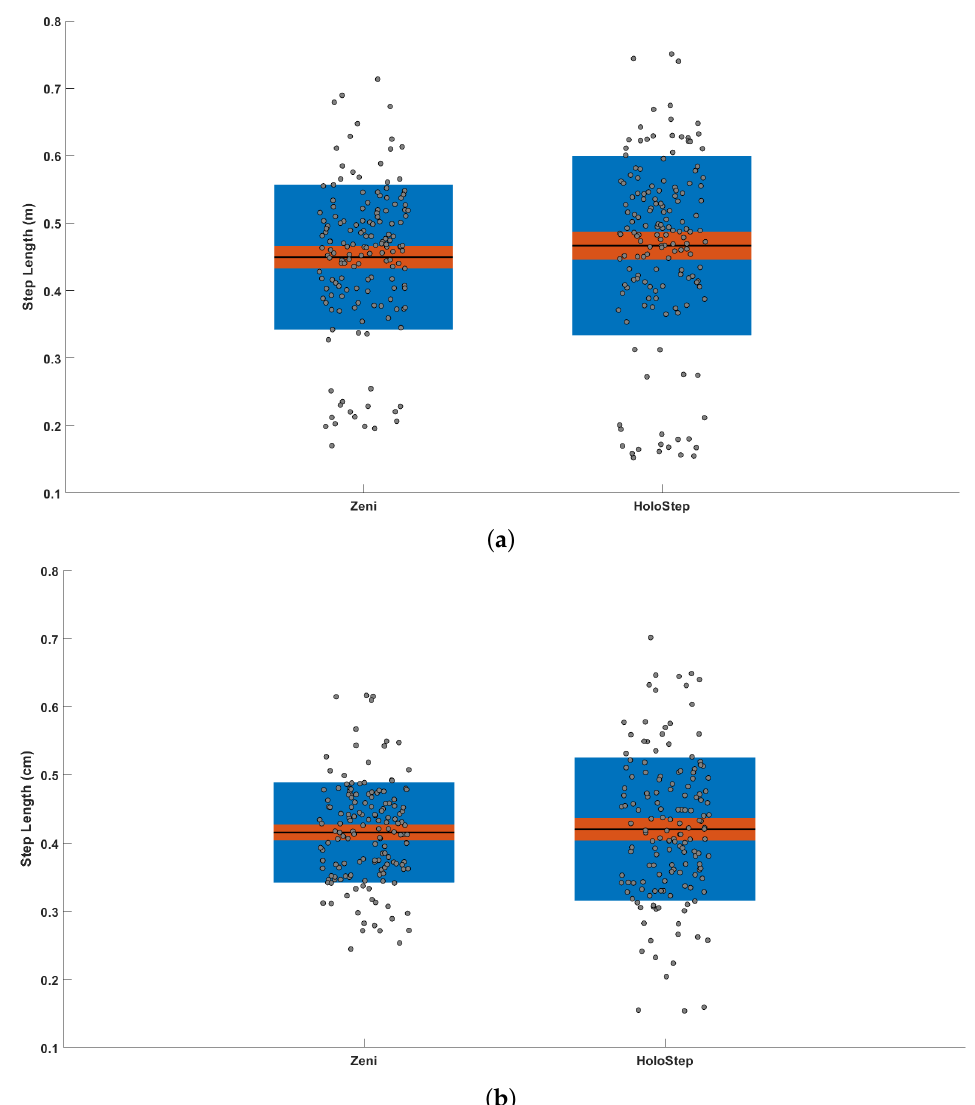
Figure 7. Difference between HoloStep and Zeni algorithm. Box plot visualizing raw data along the mean, 95% confidence interval, and 1 SD. ( a ) Children with CP—Group 1 ( b ) Children with CP—Group